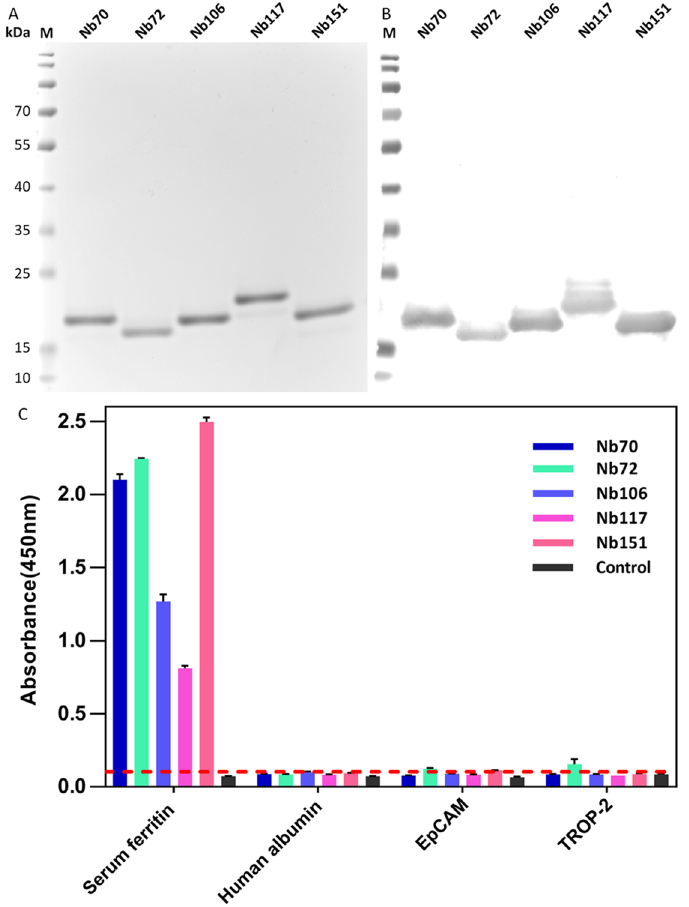
Figure 4. Preparation and confirmation of selected Nbs. ( A ) The purity and molecular size of HA- and His-tagged Nbs was verified by SDS-PAGE. ( B ) The identity of selected Nbs was analyzed by Western Blot. ( C ) Indirect ELISA was performed to detect binding specificity of selected Nbs and cross-reactivity with other proteins such as human albumin, EpCAM, and TROP-2. The cut-off value below 0.1 was considered the threshold for no cross-reaction. All data are expressed as mean ± SD ( n = 3) and repeated at least 3 times.